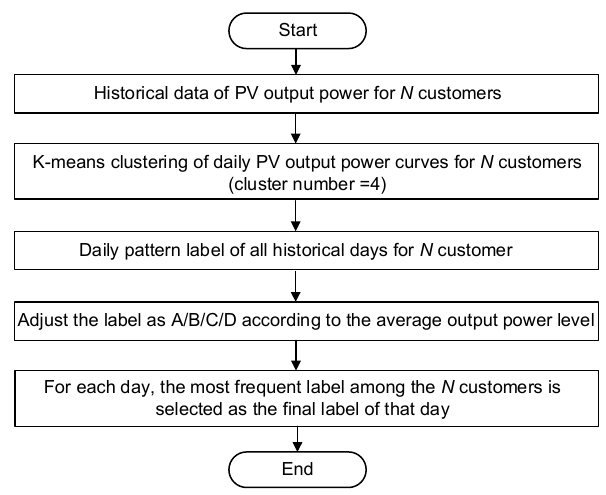
Figure 2. The flow chart of the GWC label generating method.